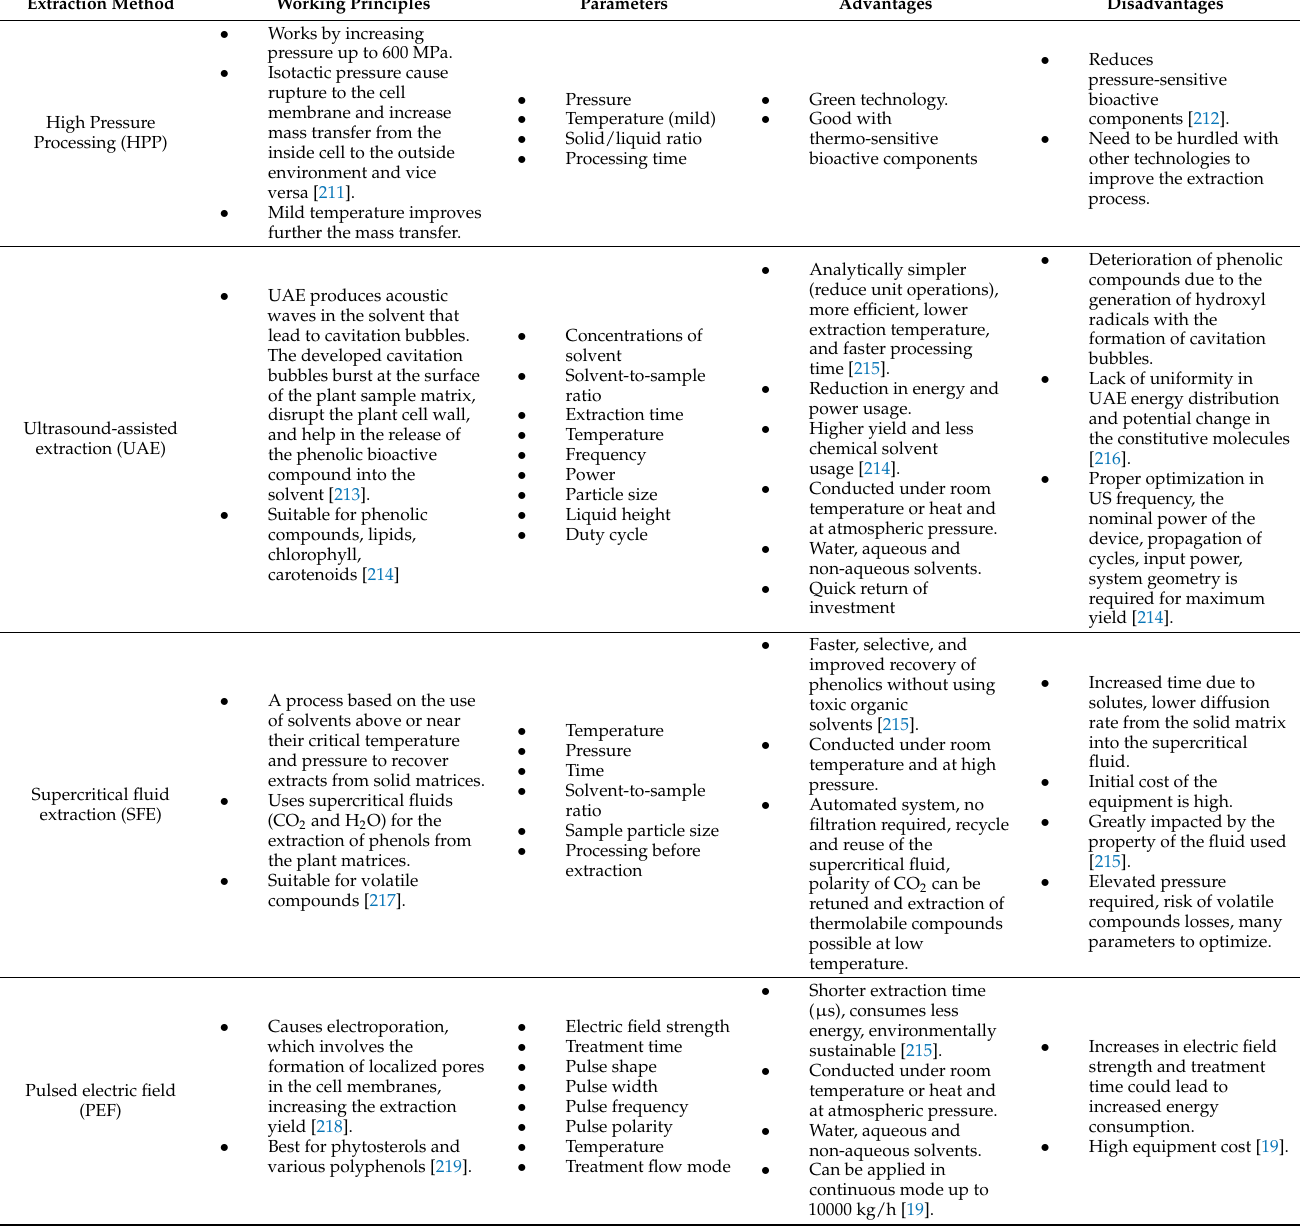
Table 9. Comparison of innovative extraction